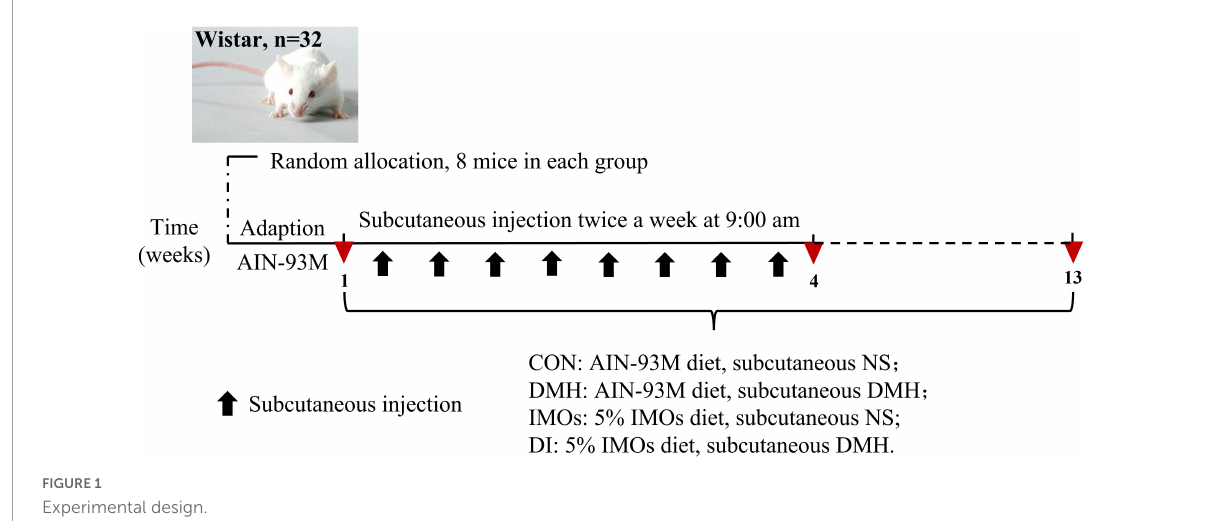
FIGURE1 Experimental